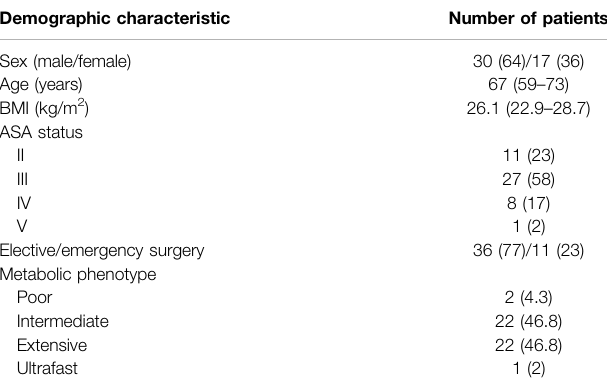
TABLE1| Demographiccharacteristicsofpatientsand CYP2D6 phenotype.Data are presented as median (interquartile range), or N and ratio (%). BMI, body mass index; ASA, American Society of Anesthesiologists Physical Status Classi fi cation System.